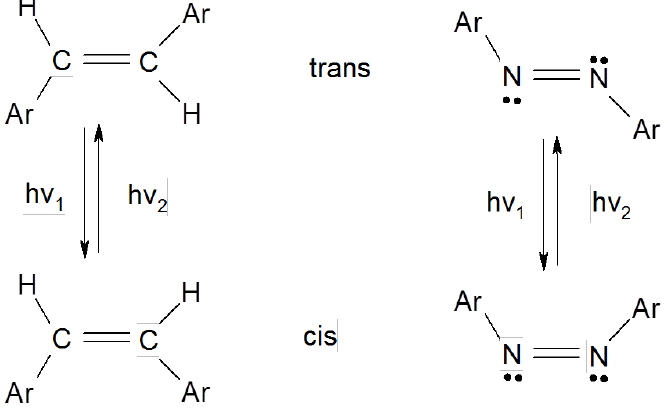
Figure 4. Reverse trans - cis isomerization is involved by the light absorption of different lengths, Ar–aryl (phenyl, naphtyl and etc.